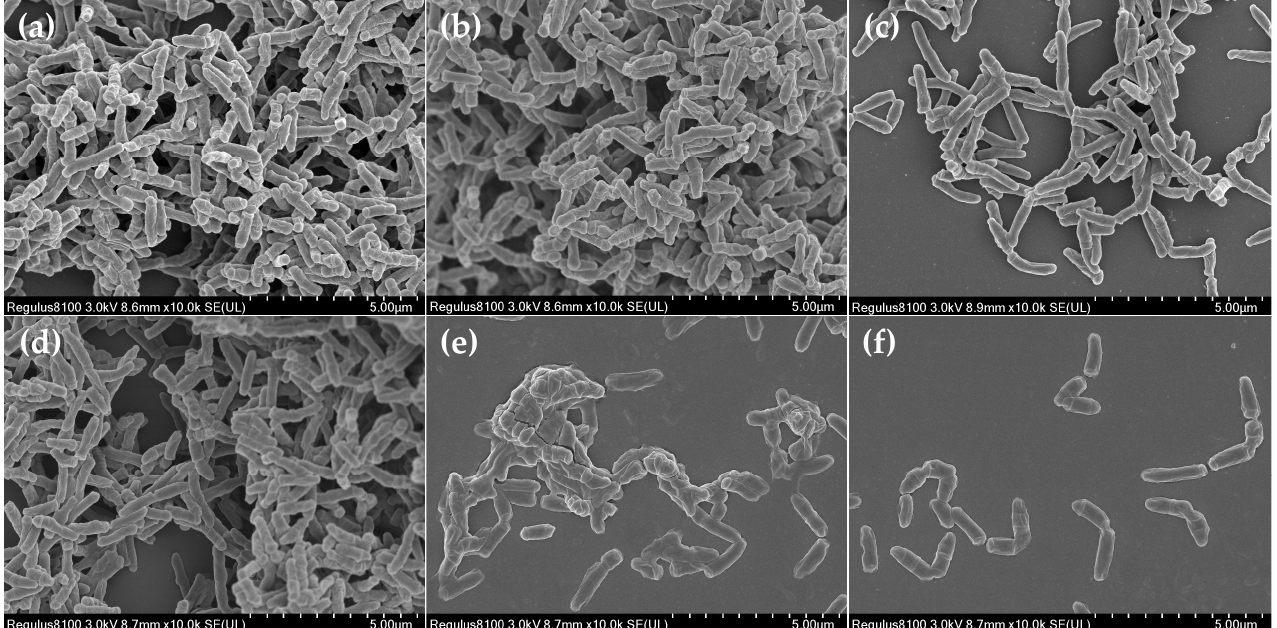
Figure 4. SEM analysis of mature T. pyogenes (BMH06-3) biofilm disruption treated with 312 µ g/mL luteolin. ( a ) Blank control biofilm. ( b ) Solvent control biofilm (1% DMSO). ( c ) Mature biofilm treated with ceftiofur (0.25 ng/mL) for 24 h. ( d – f ) Mature biofilm treated with 312 µ g/mL luteolin for 12, 18 and 24 h.